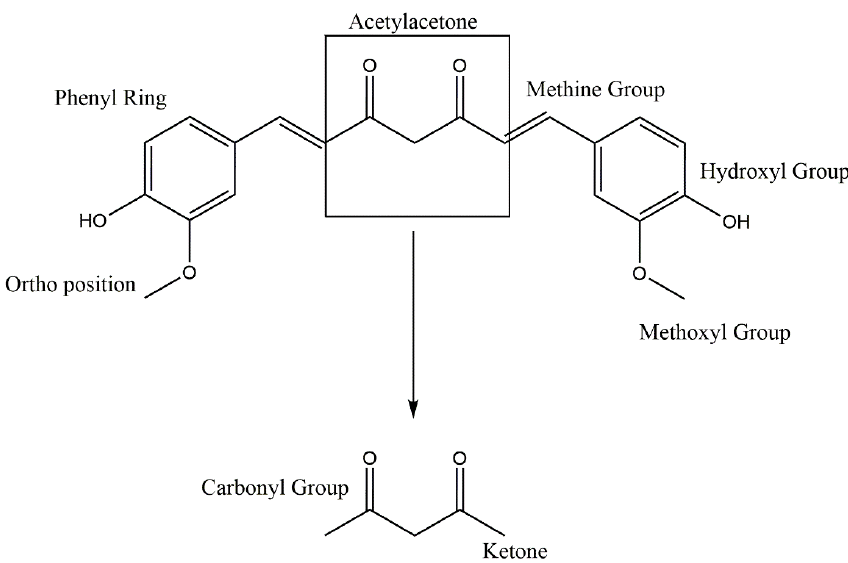
Figure 2. Functional groups in the molecular structure of curcumin.